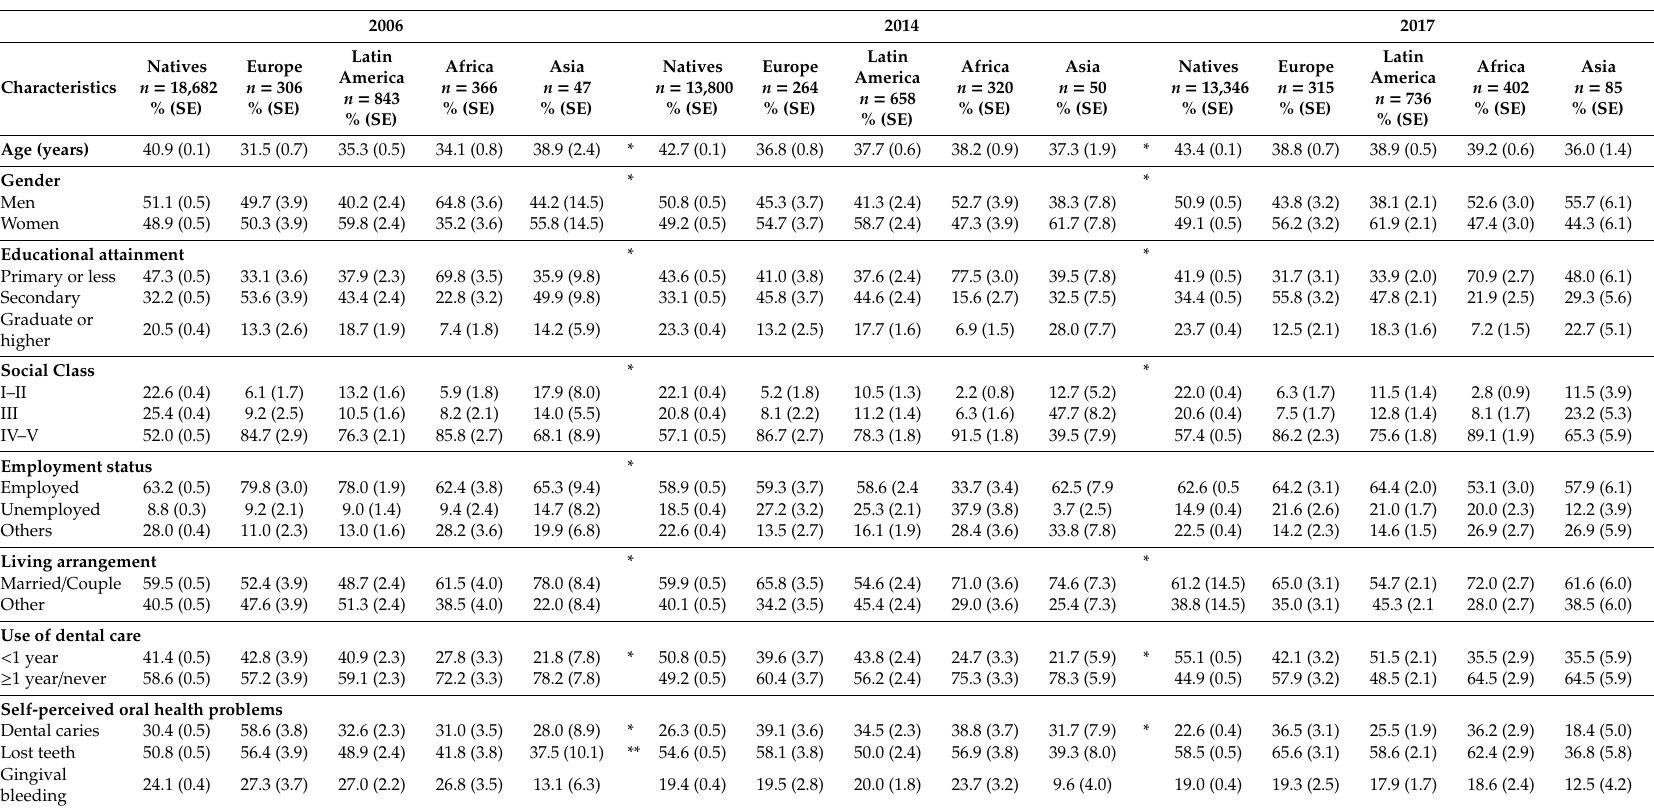
Table 1. Distribution of selected characteristics for participants of the Spanish National Health Survey 2006 and 2017 and European Health Survey in Spain 2014 according to place of